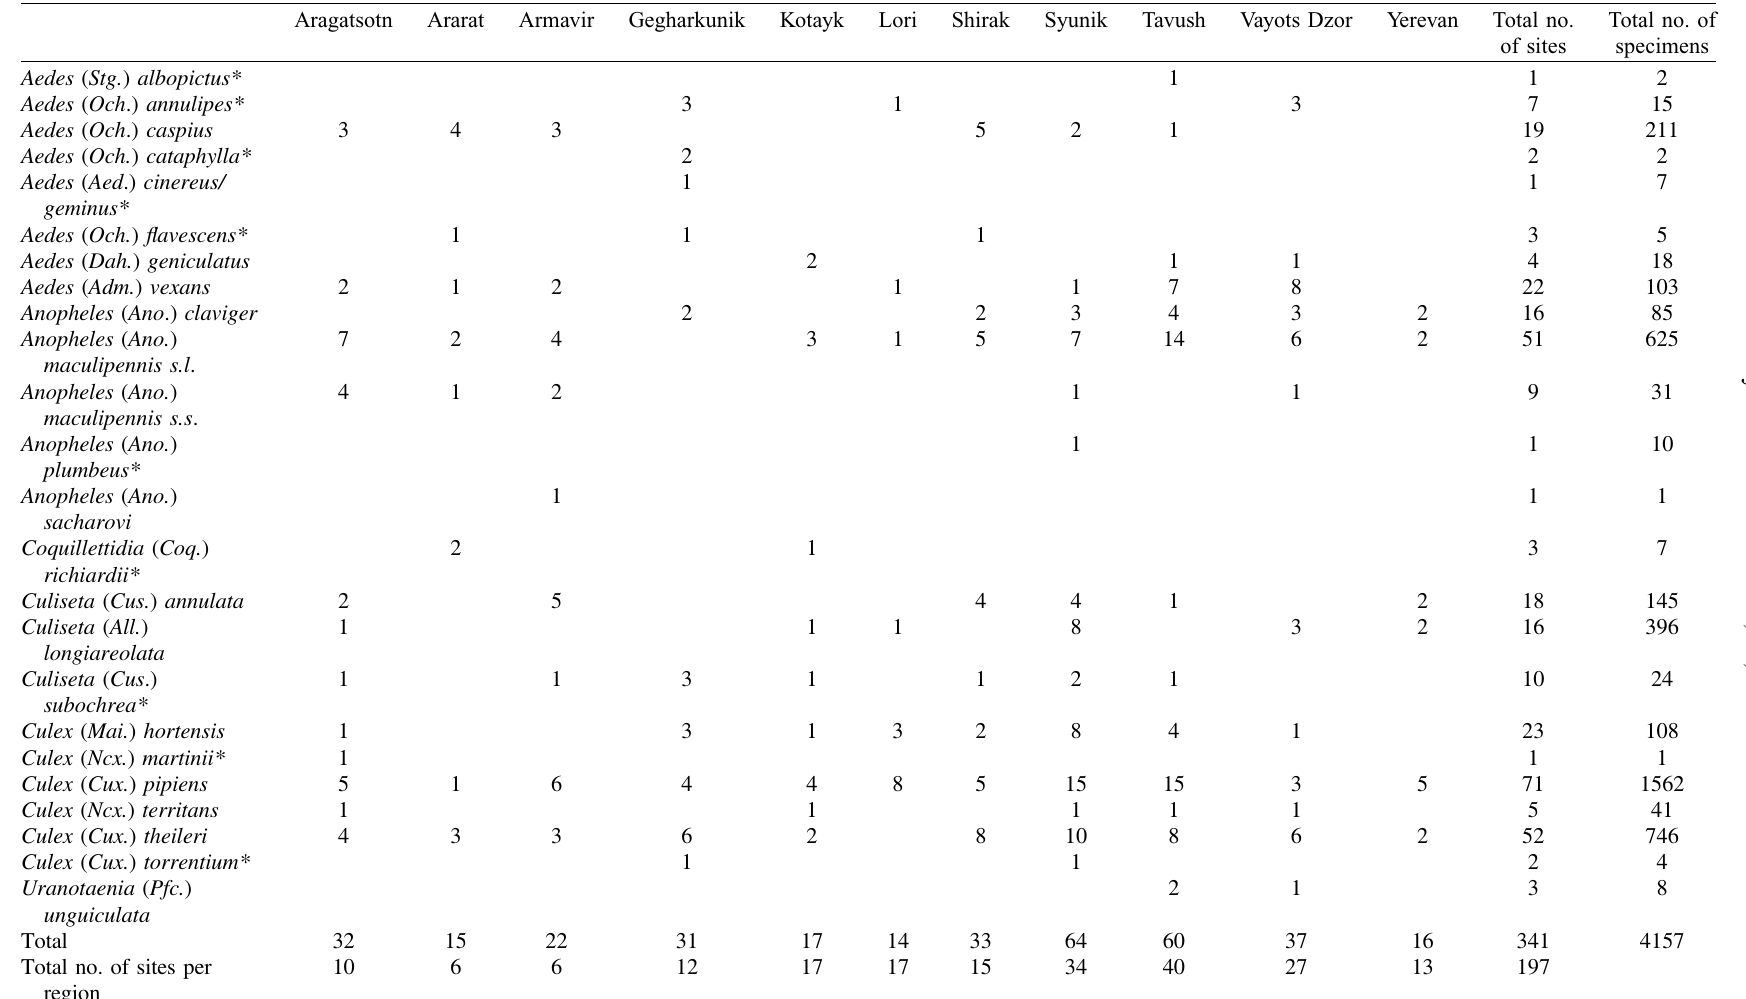
Table 2. Number of positive sites per mosquito species recorded in Armenia in 2016, according to regions. Asterisk indicates a fi rst record for Armenia. Aragatsotn Ararat Armavir Gegharkunik Kotayk Lori Shirak Syunik Tavush Vayots Dzor Yerevan Total no.